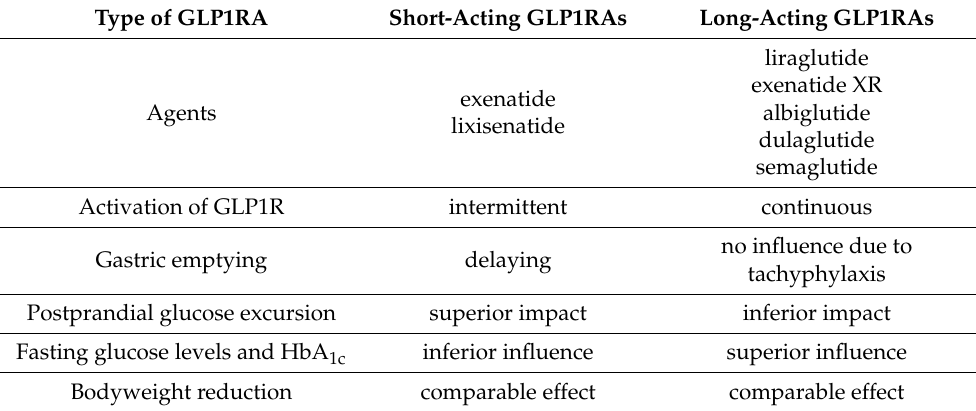
Table 1. Comparison of short-acting and long-acting